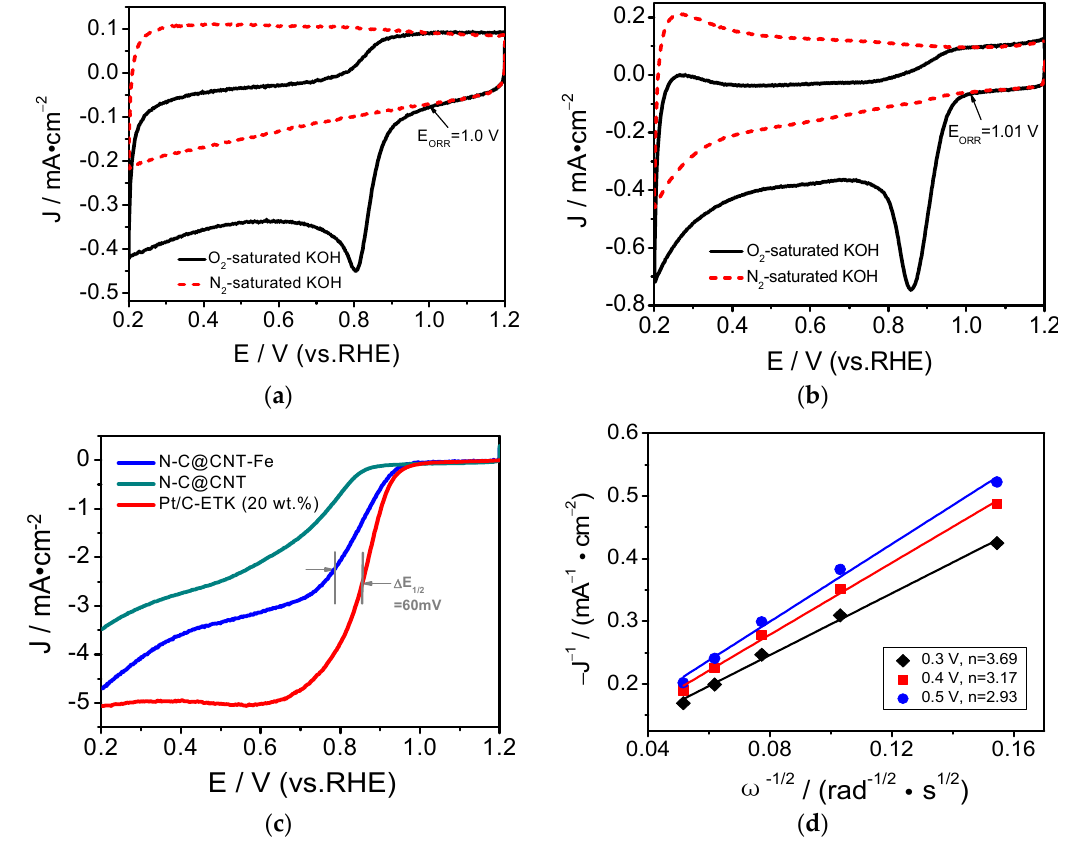
Figure 5. Cyclic voltammetry curves of N-C@CNT ( a ) and N-C@CNT-Fe; ( b ) in O 2 or N 2 -saturated 0.1 mol·L − 1 KOH solution; ( c ) LSV curves of N-C@CNT, N-C@CNT-Fe and 20% Pt/C in O 2 -saturated 0.1 mol·L − 1 KOH solution at a rotation rate of 1600 rpm; ( d ) Koutecky–Levich plots of J − 1 vs. ω − 1/2 ; Data were obtained from ( c ).